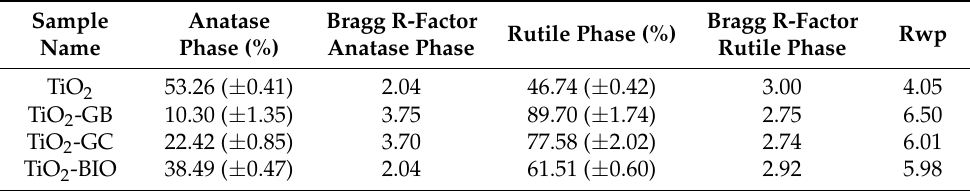
Figure 2. XRD data including Rietveld refinement approach. ( a ) TiO 2 powder without surfactant; ( b ) TiO 2 -GB powder with GBAC18:1; ( c ) TiO 2 -GC powder with GBACoco; and ( d ) TiO 2 -BIO powder with Lansperse BIO868. Table 1. Rietveld refinement